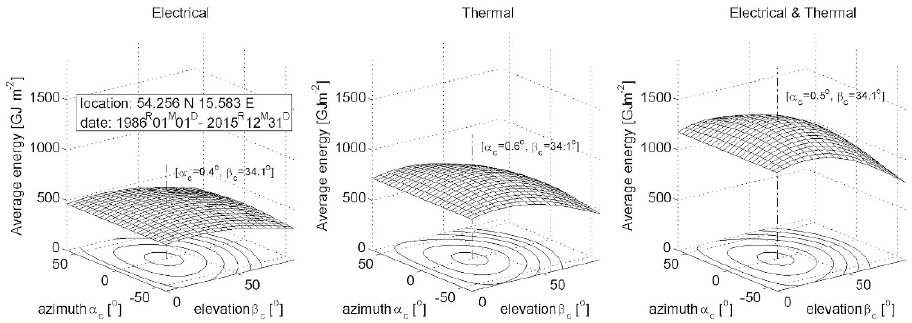
Figure 6. Optimal orientation of the absorber surface in the analyzed 30-year period.